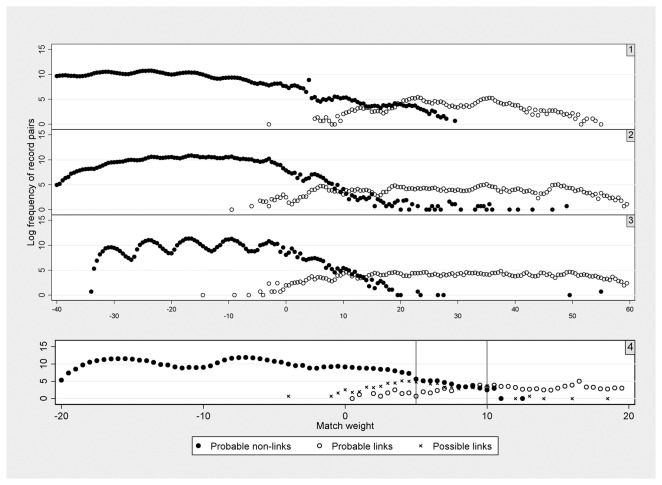
Four iterations for match weight calculation.Lines=thresholds.